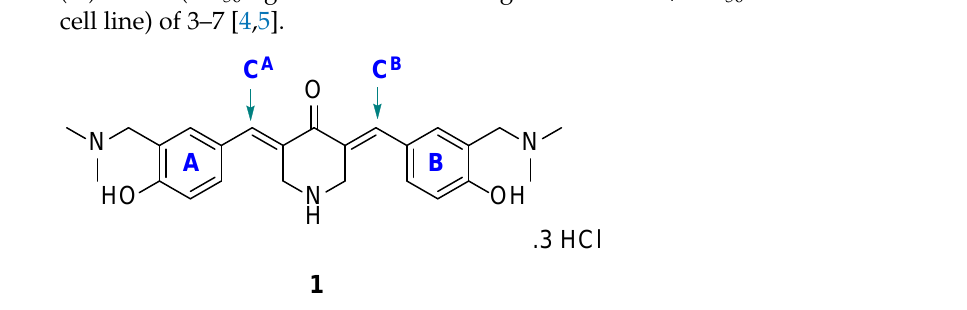
Figure 1. Structure of 1 .